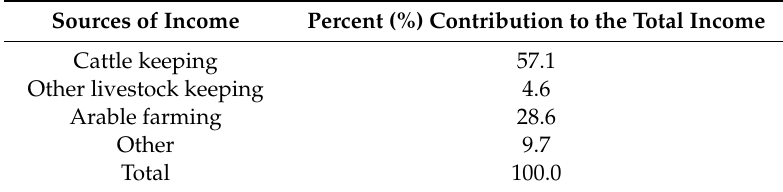
Table 2. Source of income of local people in and around Tieqiaoshan Provincial Nature Reserve.